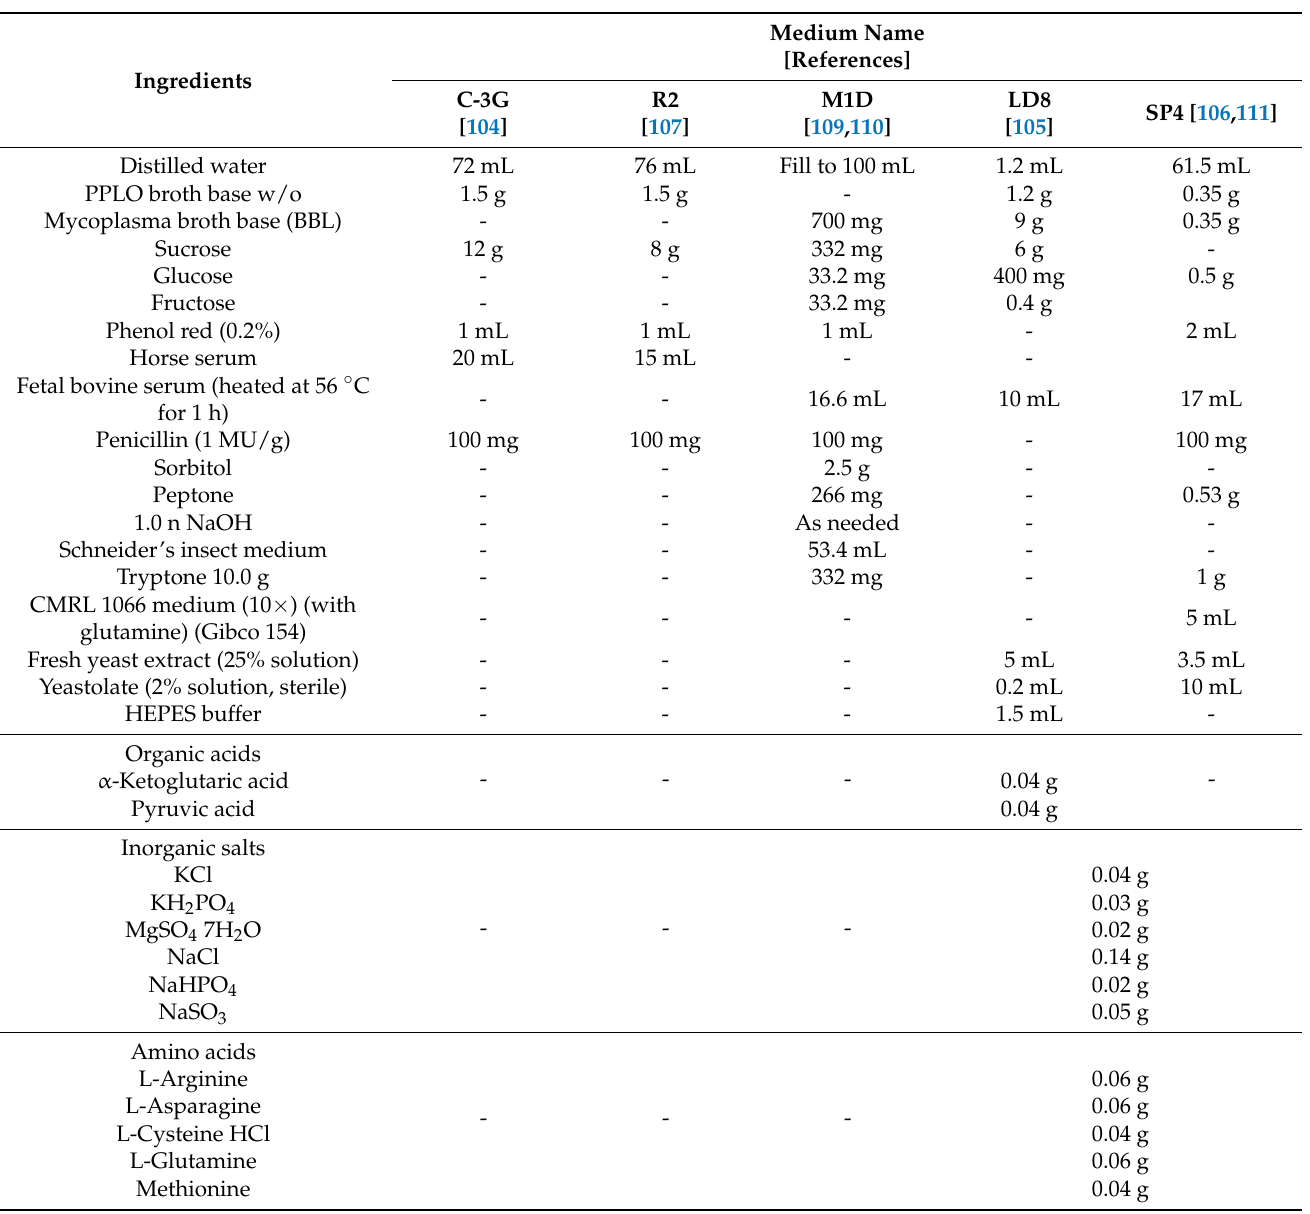
Table 2. Summary of the major medium culture used for Spiroplasma citri isolation and